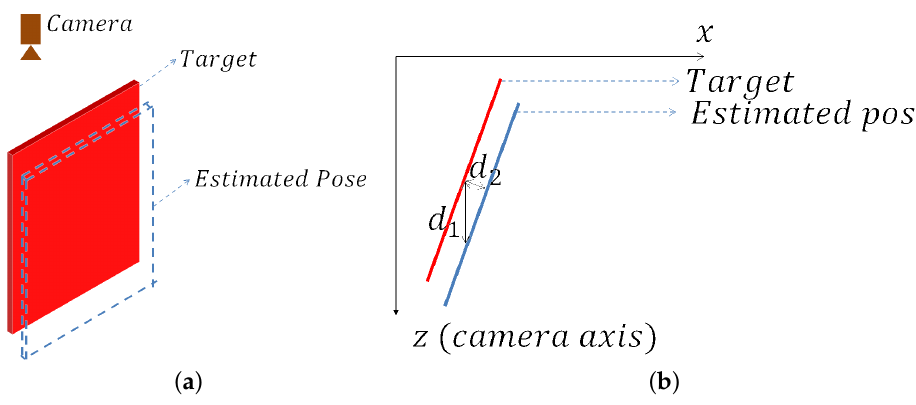
Figure 9. The difference between depth verification and inverse verification. ( a ) the target is the red planar object and the blue dotted lines present the estimated pose; ( b ) the object and pose shown in 2D. Suppose the z -axis is the camera axis, the red line is the scene points of the object we want to estimate and the blue line is the estimated pose. If the pose is evaluated by the inverse verification method, the error should be d 2 . However, if it is evaluated by the depth method, the error will be d 1 , which is much